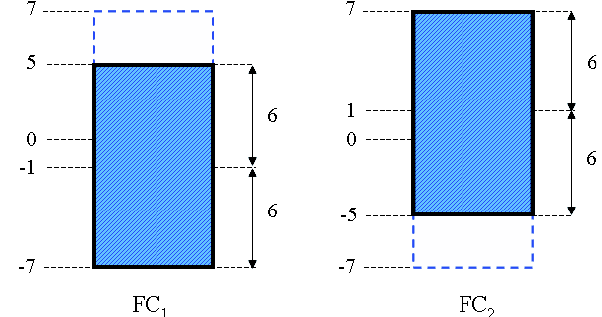
FIG. 9. (Color) Sections in the x - y plane of the poles after the modification in case the beam trajectory is at negative ( FC ) or positive ( FC and FC 5